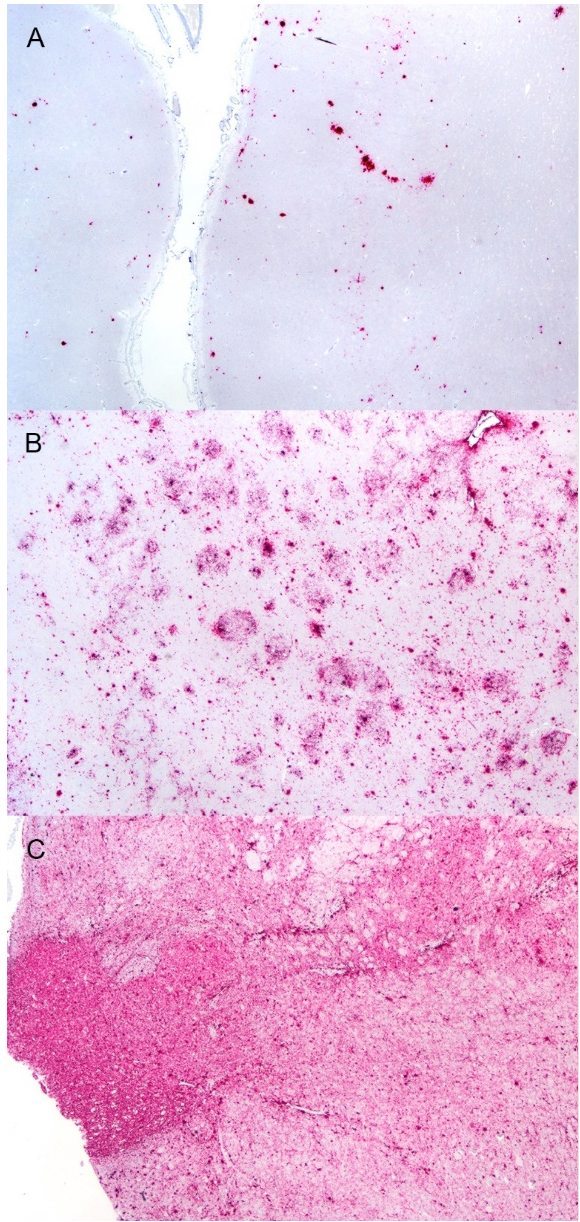
Figure 3. The relative degree of PrP Sc immunolabeling in the brain of deer with raccoon-passaged CWD. ( A – C ) Images depict mild (+), moderate (++), and severe (+++) amounts of PrP Sc in the brain. Immunohistochemistry, F99 monoclonal antibody. Original magnification ( A – C ), 40×. The densest areas of immunolabeling were in the olfactory bulb, olfactory tract, and piriform cortex at the level of the basal nuclei (Figure 4), and the brainstem at the level of the obex (Table 2).